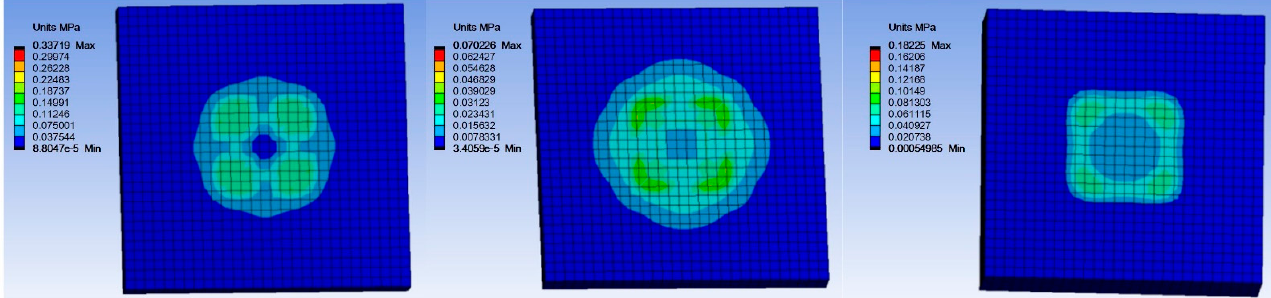
Figure 12. Sediment stress cloud map of three kind of landers’ bottom subsidence process.